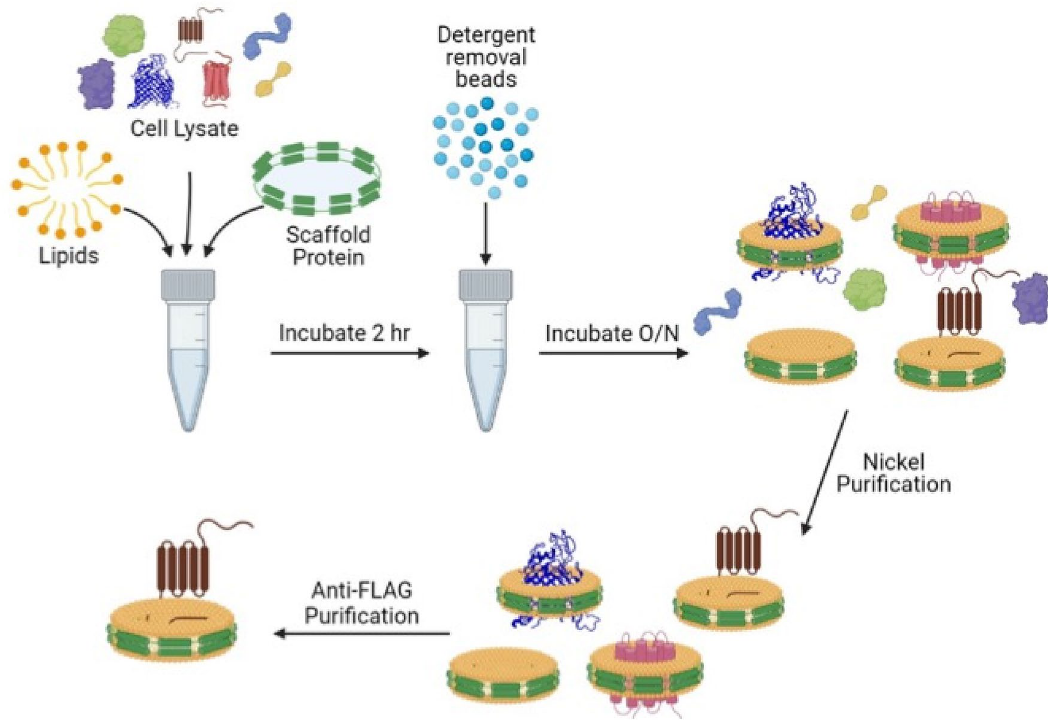
Figure 1. Scheme showing an overview of the strategy for purifying full-length viperin incorporated into nanodiscs. Lysate from HEK293T cells transiently transfected with viperin is mixed with scaffold protein and lipids in the presence of detergent. Removing the detergent results in the spontaneous formation of nanodiscs. Next, the nanodiscs are purified using the His-tag on the scaffold protein. Lastly, viperin-containing nanodiscs are further purified using the 3xFLAG tag on